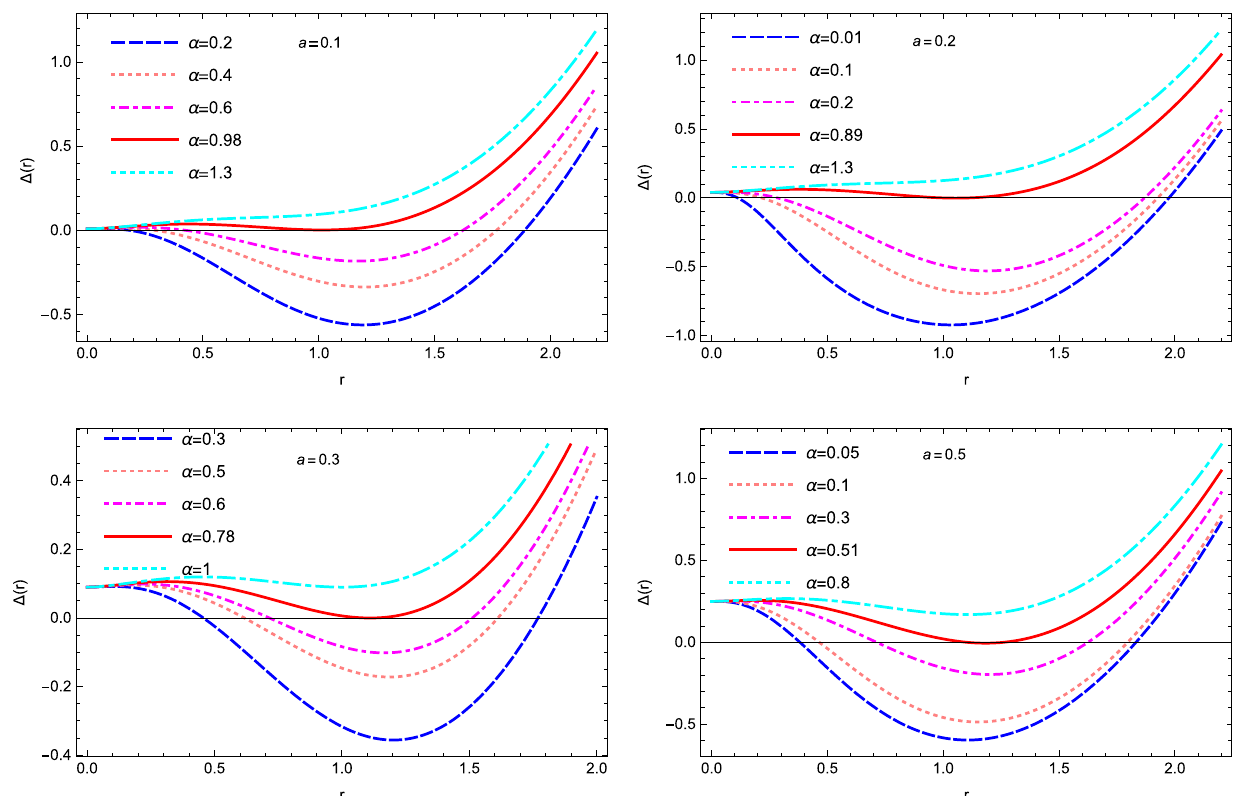
and a = 0 . 5 (bottom-right panel), respectively. In each panel the solid curve corresponds to the extremal